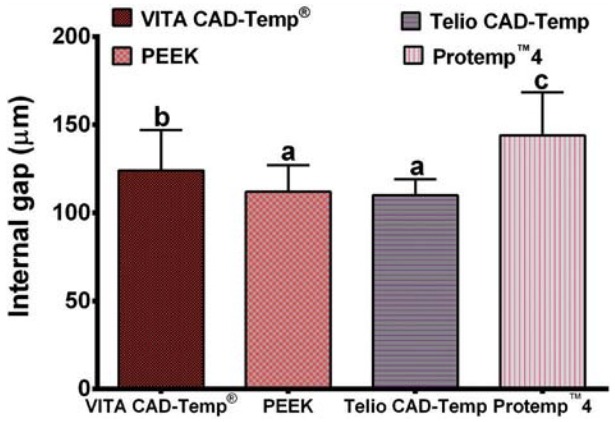
Bar graph showing the mean values and standard deviation (SD) of the internal gap for each group of material. Means with the same letter are not significantly different. Means with different letters are significantly different